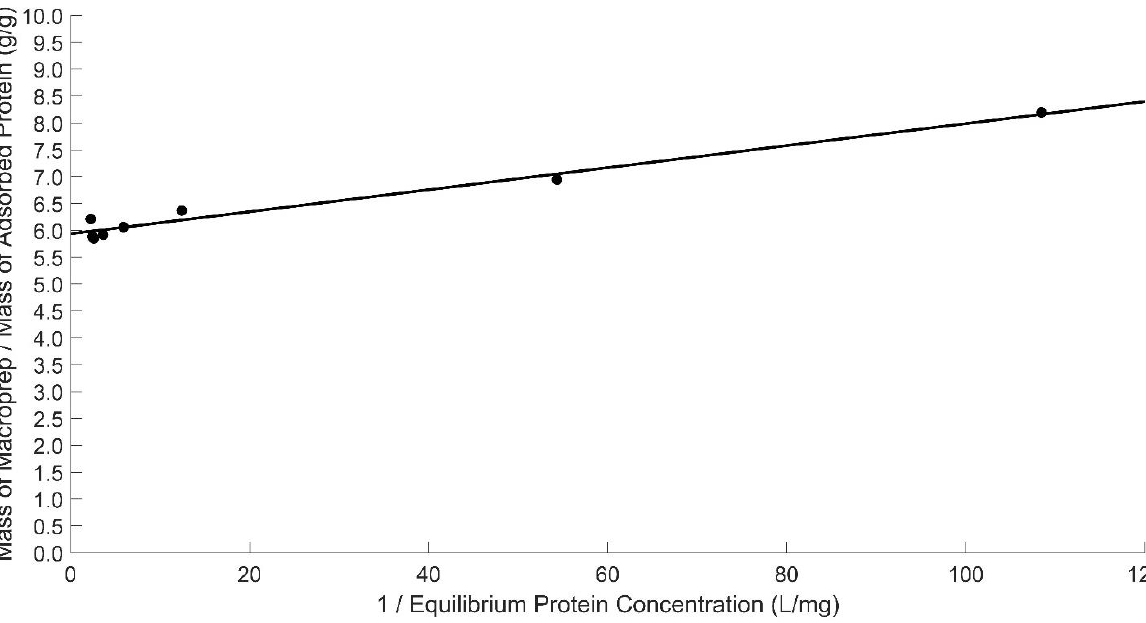
Figure 2. Lineweaver–Burk plot of Macro-Prep ® adsorption capacity in model wine solutions with pH of 3.3. Data collected by using the Bradford protein assay and a UV-Vis spectrometer at 595 nm. Table 2. Effect of pH on protein adsorption and removal from model wine solutions by the ion- exchange resin Macro-Prep ® .